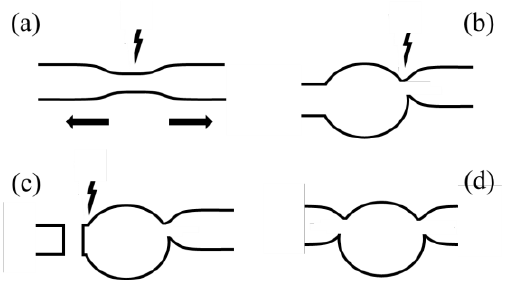
Figure 1. Fabrication scheme of head sensor based on microsphere coupled between the short taper: ( a ) taper, ( b ) cleaving of the microsphere and tip, ( c ) clamping of the stem, and ( d ) fusion of the microsphere and other taper.